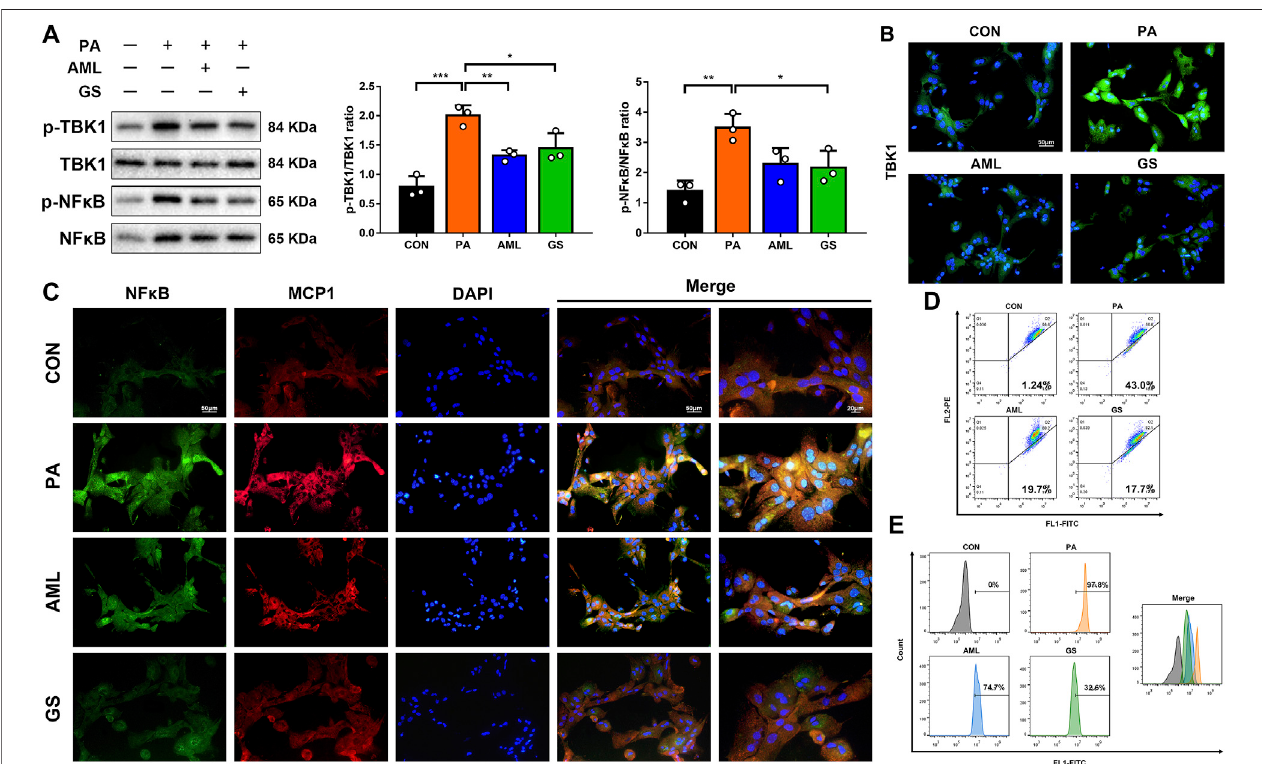
FIGURE 5 | GS regulated TBK1 to improve oxidative stress in PA-stimulated hepatocytes. (A) Western blot analyses of p-TBK1, TBK1, p-NF- κ B and NF- κ B in hepatocytes and statistical graphs, n (cid:1) 3. (B) Immuno- fl uorescence staining of TBK1. (C) Double immuno- fl uorescence staining of NF- κ B and MCP1. (D) The mitochondrial membrane potential assay was detected by JC-1, three samples were collected together for testing, and the experiment was repeated three times. Aggregates with red fl uorescence in normal cells were distributed in the second quadrant, while monomers with green fl uorescence delivered in the third quadrant represented decreased mitochondrial membranepotential. (E) The ROSassay wasdetectedwith DCFH-DA, three samples werecollectedtogetherfor testing, and the experiment was repeated three times. Results are presented as means ± SD. *p < 0.05, **p < 0.01, ***p < 0.001 .